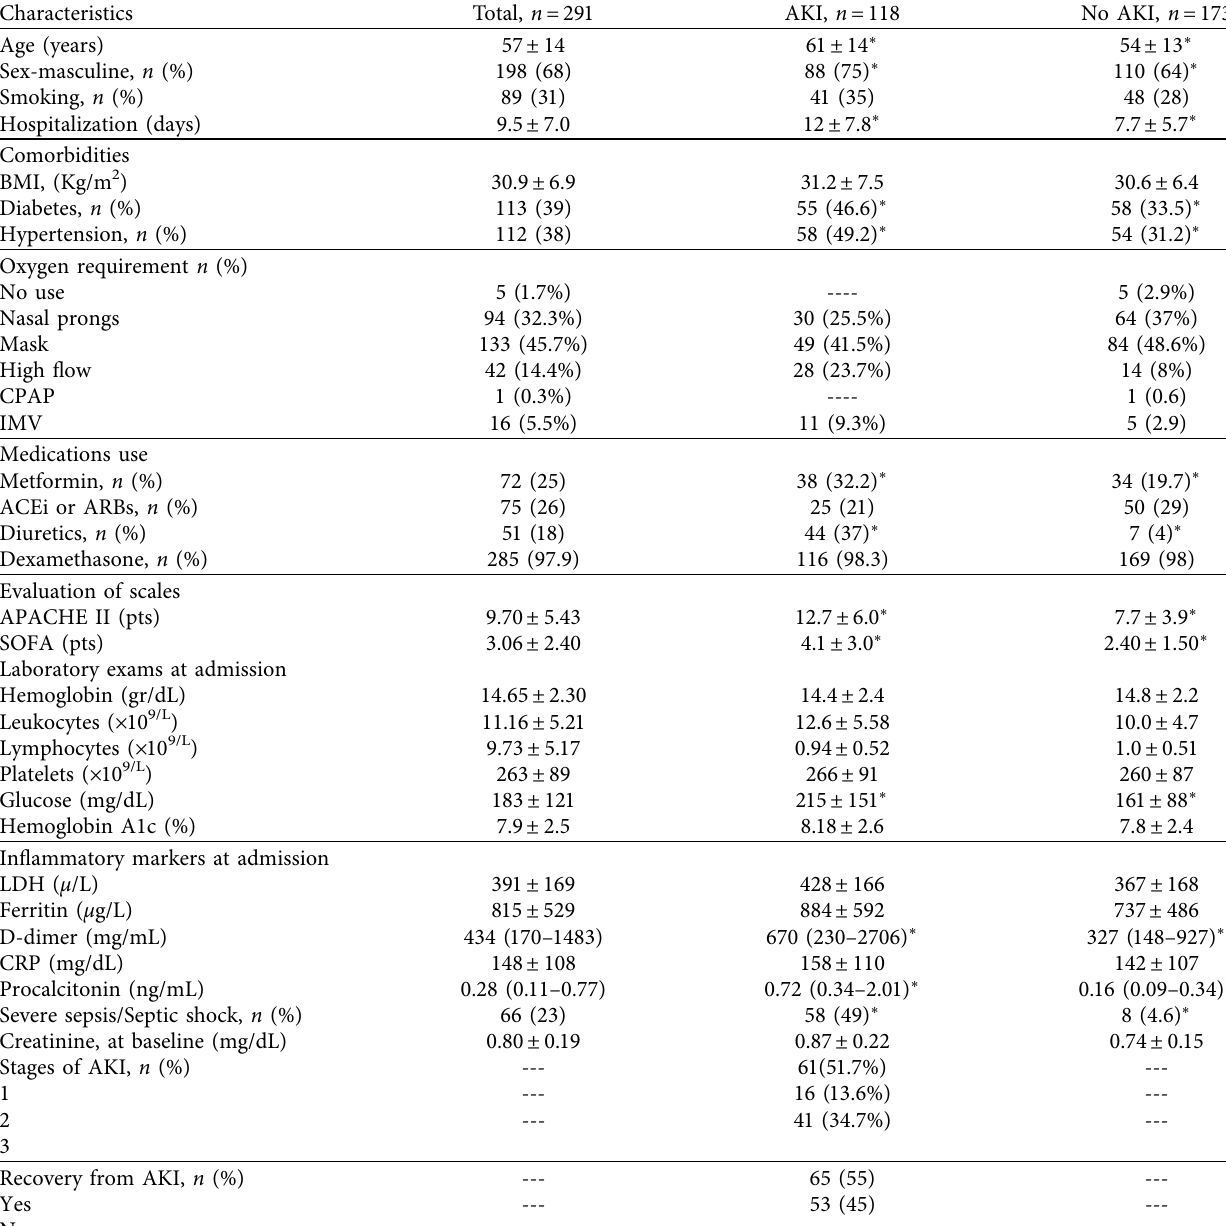
Table 1: Demographic characteristics of patients with acute kidney injury (AKI) and